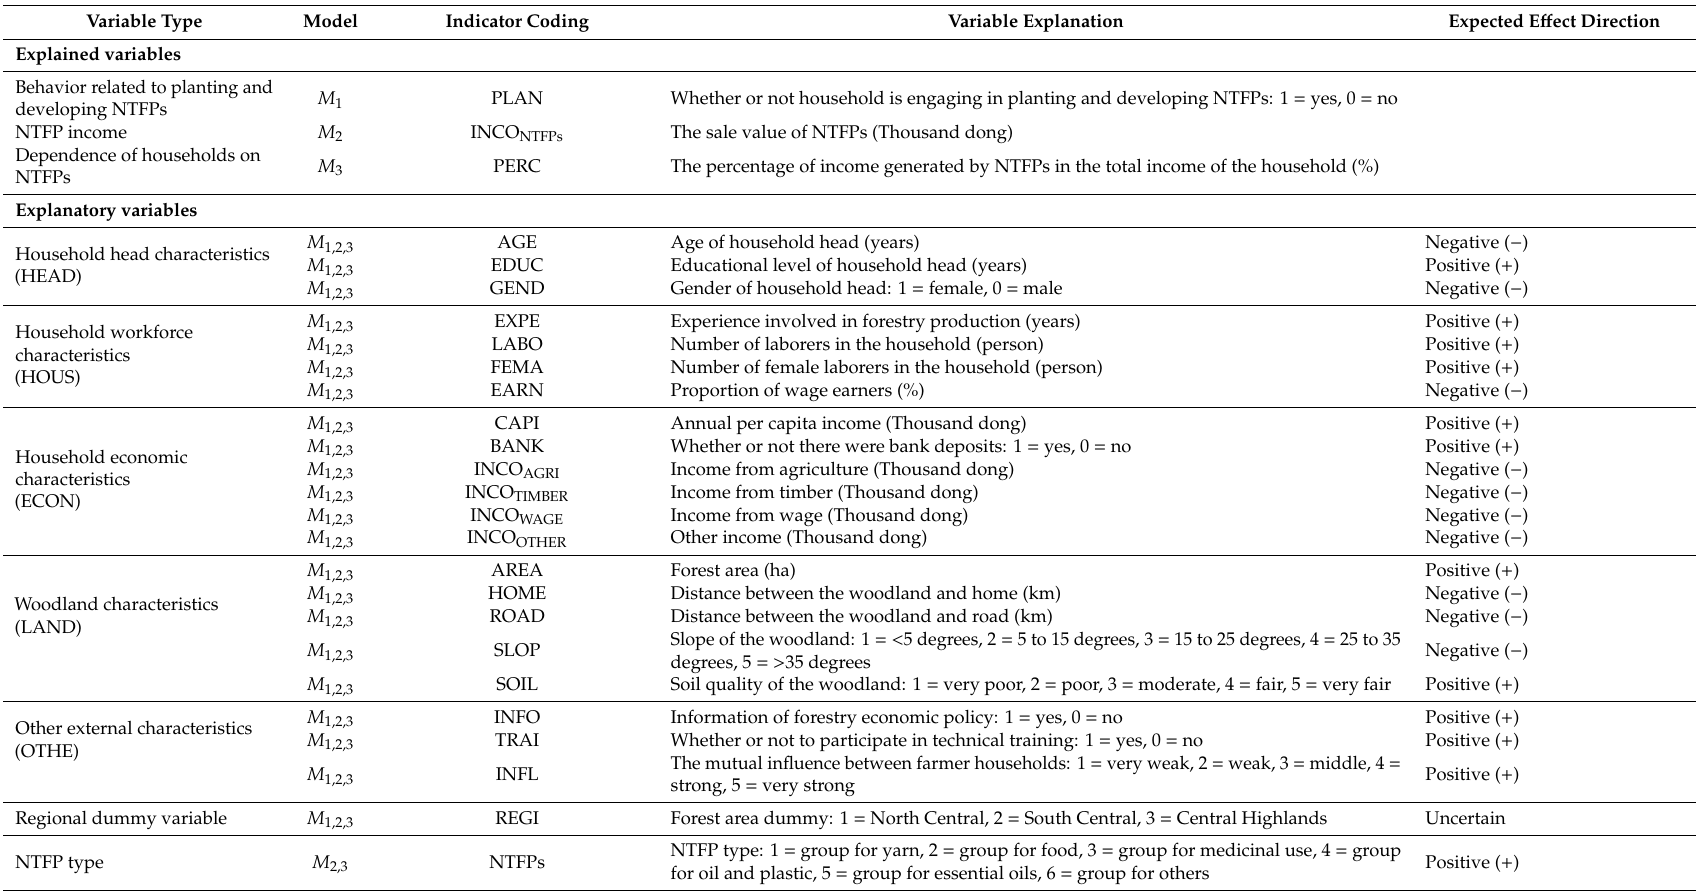
Table 1. Variable explanation and expected e ff ect